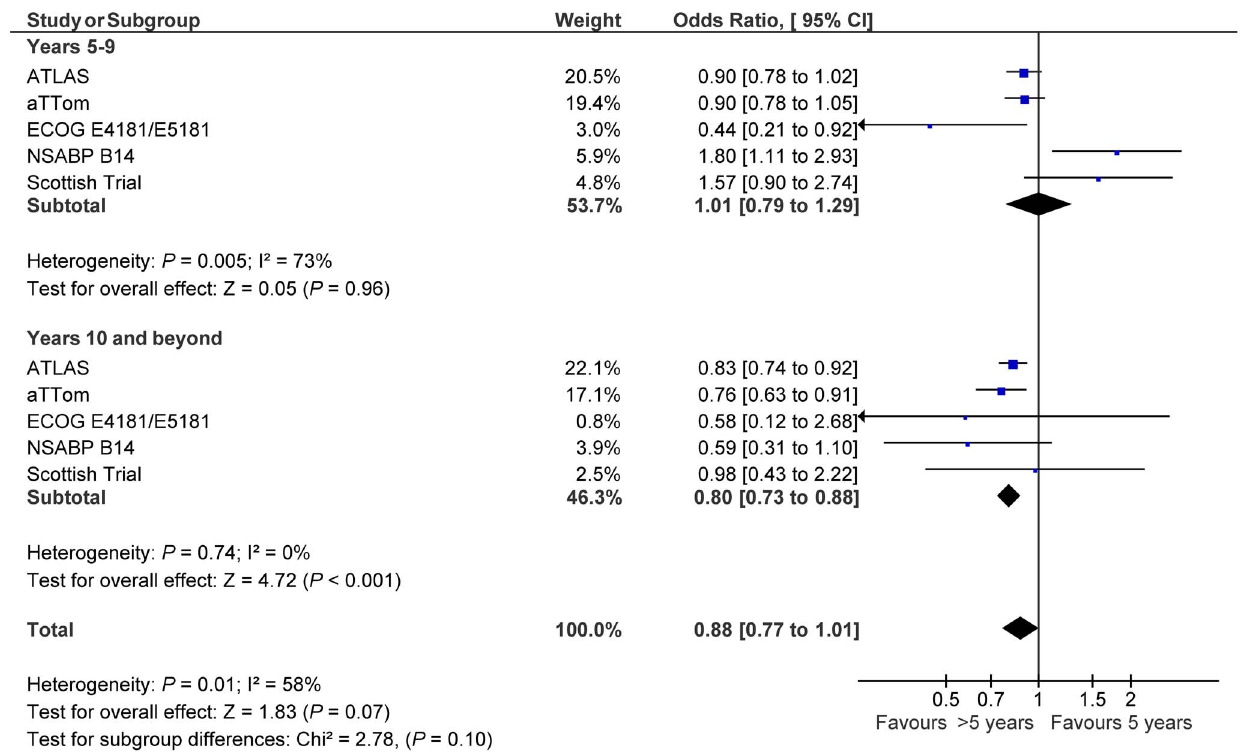
Figure 3. Forest plots of odds ratios for breast cancer recurrence between years 5–9 and in years 10 and beyond for patients treated with extended adjuvant tamoxifen ( . 5 years) versus adjuvant tamoxifen (5 years) based on primary analysis of individual trials. Odds ratios for each trial are represented by the squares , the size of the square represents the weight of the trial in the meta-analysis, and the horizontal line crossing the square represents the 95% confidence interval. The diamonds represent the estimated pooled effect based for each cohort individually (labeled subtotal) and for all cohorts together (labeled total).